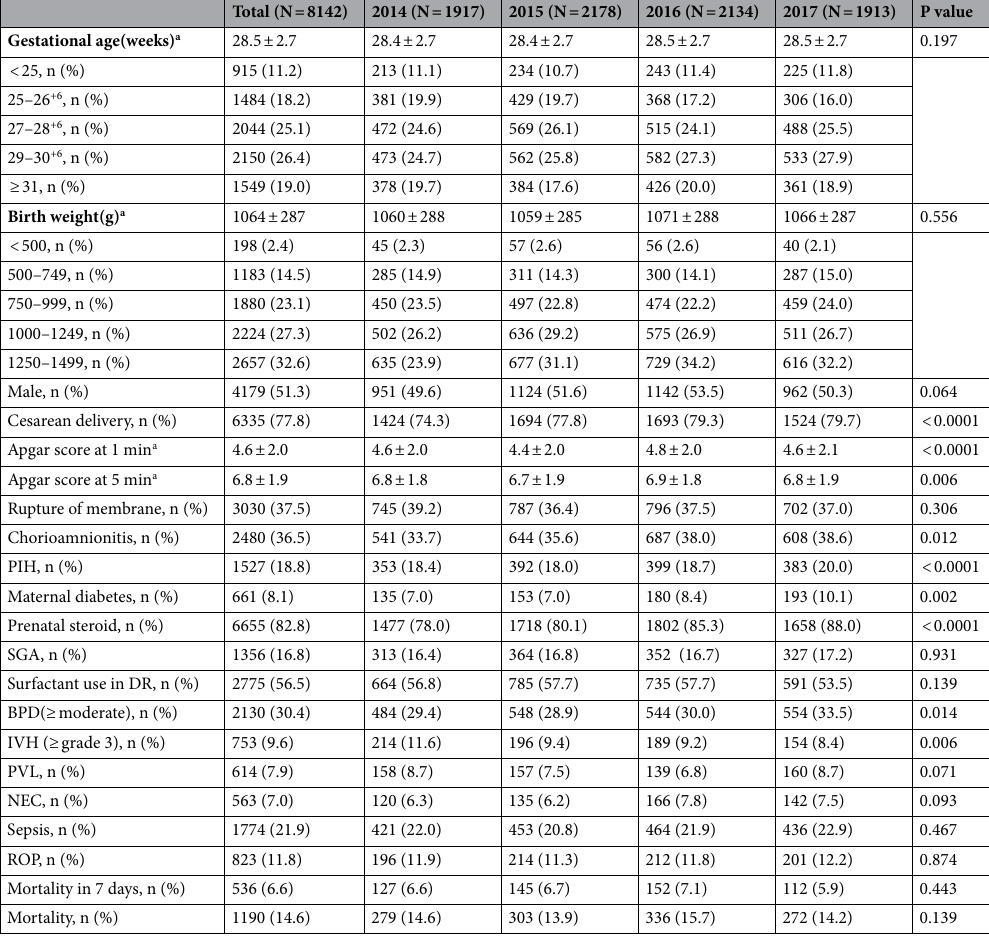
Table 1. Demographics and outcome of the very-low-birth-weight infants. PIH pregnancy-induced hypertension, SGA small for gestational age, DR delivery room, BPD bronchopulmonary dysplasia, IVH intraventricular hemorrhage, PVL periventricular leukomalacia, NEC necrotizing enterocolitis, ROP retinopathy of prematurity, SD standard deviation. a Mean ±